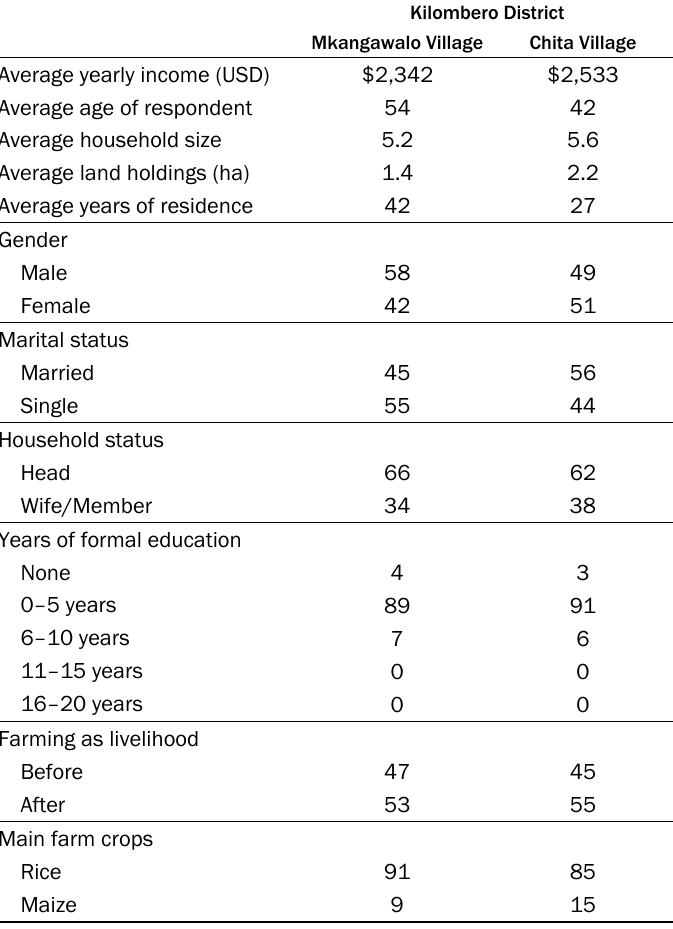
Table 1. Demographic and Household Characteristics of Respondents in the Study Area ( n